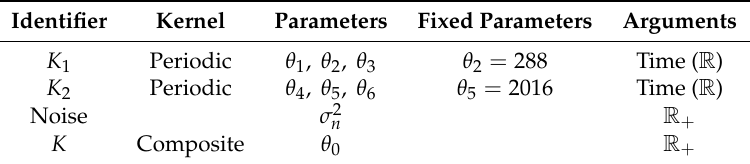
Table 1. The parameters of the composite kernel described by Equation (8).